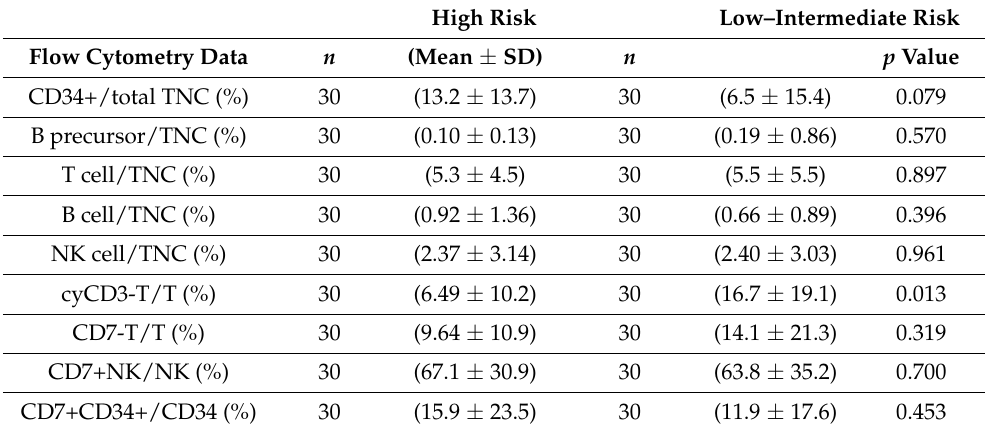
Table 3. Bone-marrow analysis of high-risk and low–intermediate-risk